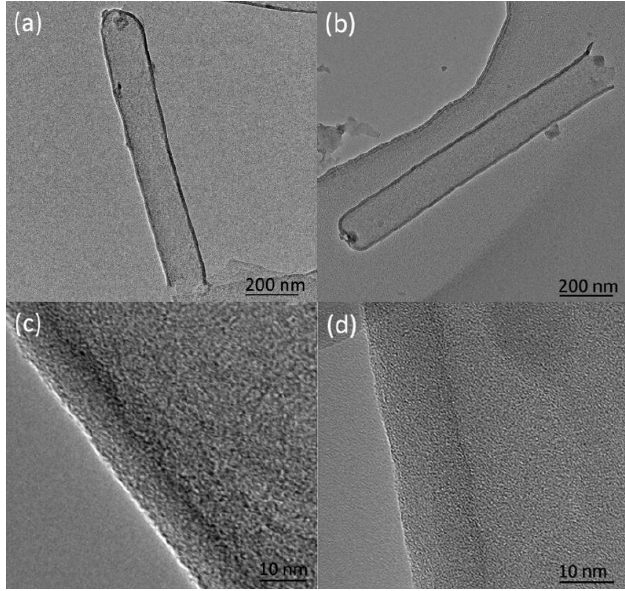
Figure 6. Transmission electron microscopy (TEM) and high‐resolution transmission electron microscopy (HRTEM) images of carbon nanotubes prepared at different deposition times: ( a ) TEM, 1.5 h; ( b ) TEM, 2 h; ( c ) HRTEM, 1.5 h; ( d ) HRTEM, 2 h.